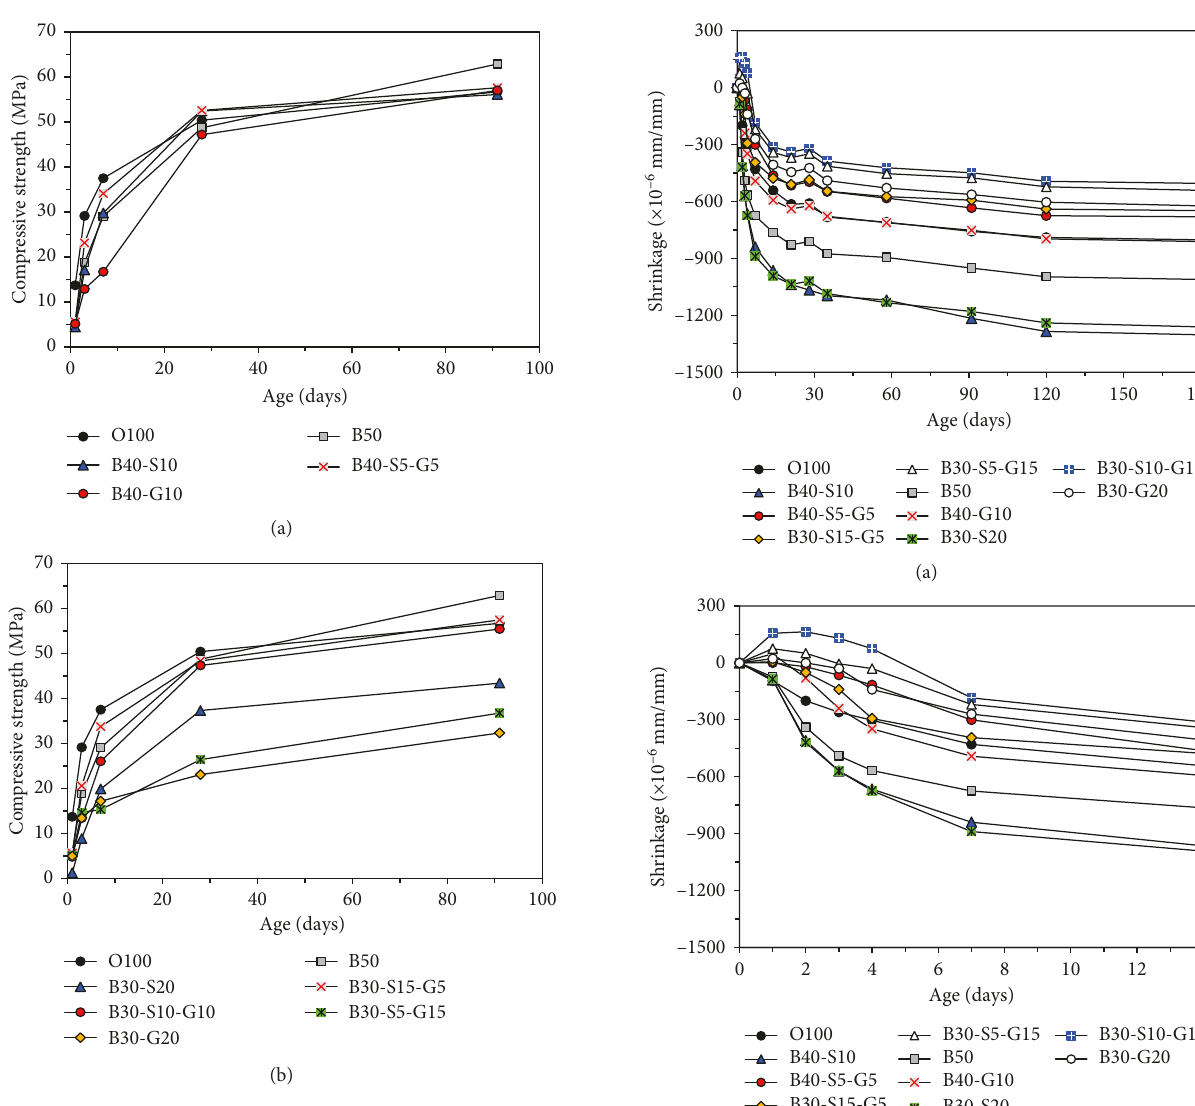
Figure 5: Development of compressive strength with binder types.